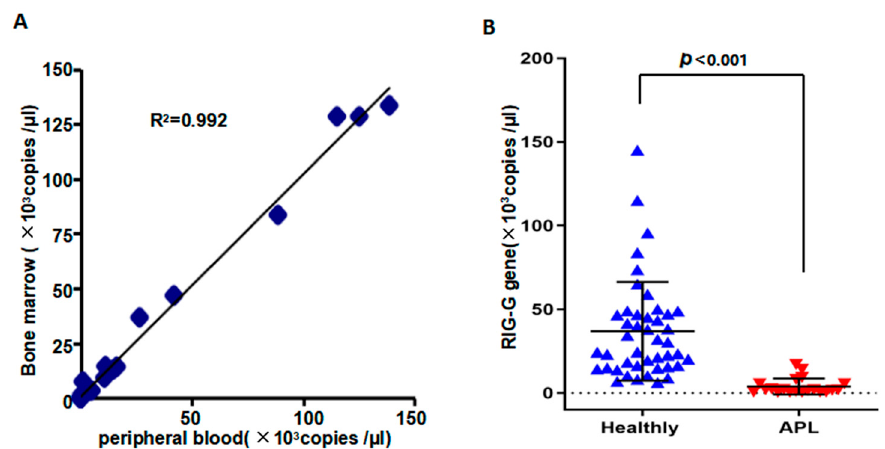
Figure 3. The expression and correlation of RIG-G in healthy donors and APL (M3) patients. ( A ) The correlation of RIG-G gene expression in peripheral blood and bone marrow showed no significant difference ( n = 12, p > 0.05), indicated that consistency of two methods was good (R 2 = 0.992). ( B ) The expression of RIG-G gene in peripheral blood of APL patients was markedly lower than that of healthy control group, with a difference that was statistically significant ( p < 0.001).